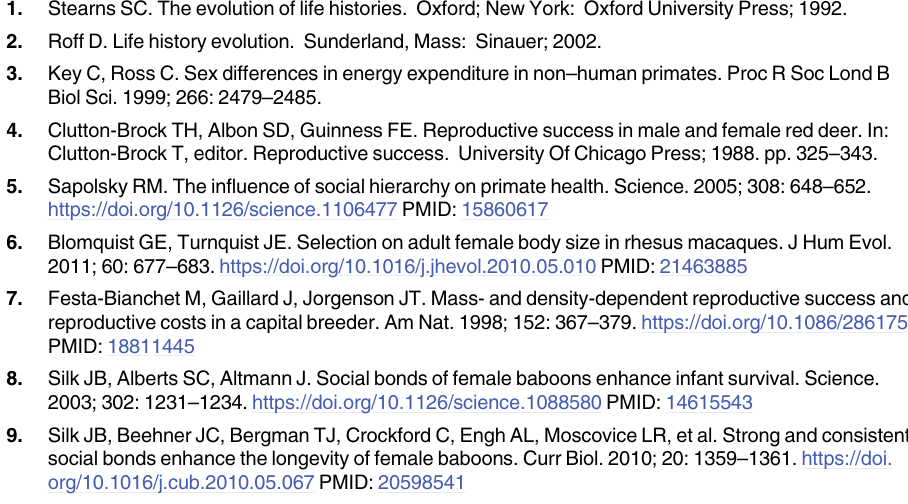
S2 Table. Inter-birth interval analysis. S3 Table. Infant mortality